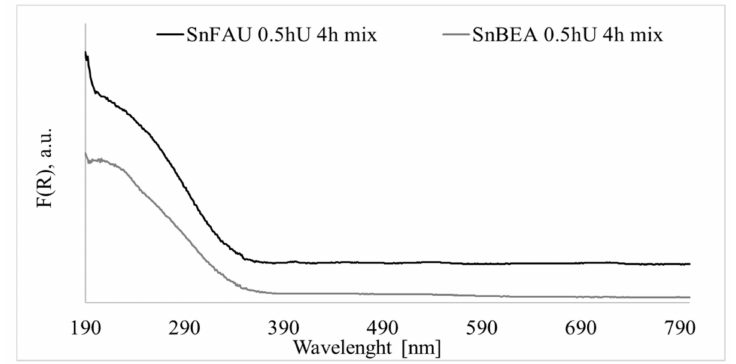
Figure 4. Ultraviolet and visible-light diffuse reflection (DR UV-Vis) spectra of hierarchical